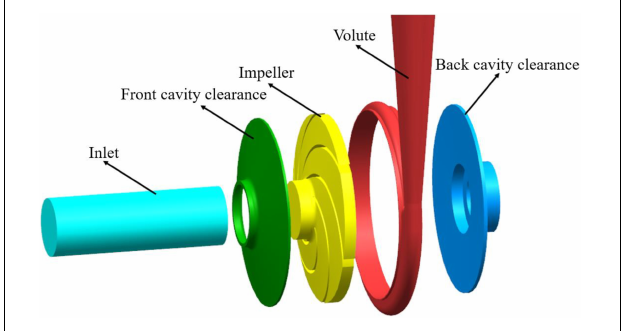
FIGURE 1 | Diagram of the computational domain of flow